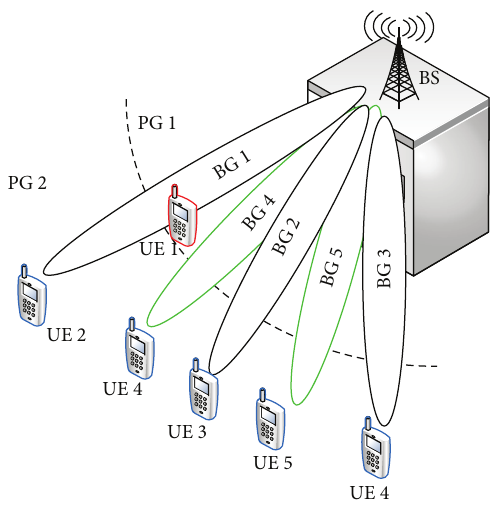
Figure 1: A massive MIMO BS to serve randomly located